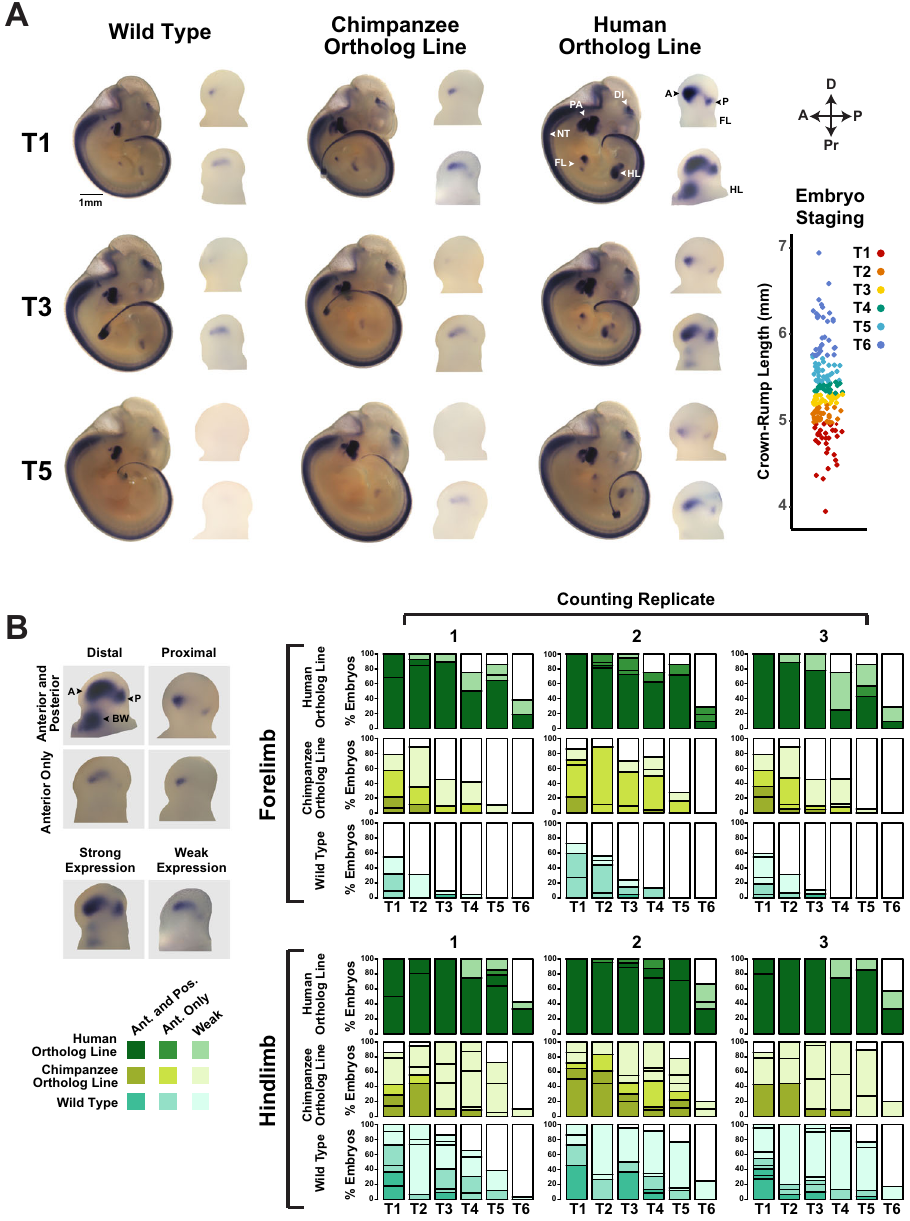
Fig. 3 Spatial and temporal changes in Gbx2 expression driven by HACNS1 in HACNS1 knock-in mouse embryos. A Spatial and temporal expression of Gbx2 in HACNS1 homozygous, chimpanzee ortholog line, and wild type E11-E12 embryos visualized by whole-mount in situ hybridization (ISH). Representative images are shown for each genotype at three fi ne-scale time points; see text and associated Source Data for details on staging. Magni fi ed views of Gbx2 expression in limb buds are shown to the right of each embryo. Annotations of anatomical structures and developmental axes are indicated at the top right: FL forelimb, HL hindlimb, DI diencephalon, NT neural tube, PA pharyngeal arch, A anterior, P posterior. The arrows at the top far right indicate the anterior-posterior (A-P) and proximal-distal (Pr-D) axes for the magni fi ed limb buds. Bottom right: Crown-rump lengths for all embryos assayed for Gbx2 mRNA expression by ISH. Each point indicates a single embryo. Colors denote each fi ne-scale time point (T1-T6). B Left: representative images of anterior, posterior, proximal, distal (top), and strong versus weak Gbx2 staining patterns (bottom). Anterior (A), posterior (P), and body wall (BW) domains are denoted on top left limb bud. Right: Gbx2 ISH staining pattern data across 6 developmental timepoints from each of three independent, blinded scorers (marked at top as counting replicates 1 – 3; see text and Fig. 3A for timepoint scheme and associated Source Data for annotations). The darkest shade for HACNS1 homozygous (dark green), chimpanzee ortholog line (olive), and wild type (teal) represents percentage of forelimbs or hindlimbs showing strong anterior and posterior limb bud staining. Medium-dark shade, as shown in the legend on the left, denotes strong anterior staining only, while the lightest shade denotes weak staining in any domain. Independent biological specimens were analyzed for n = 139 (wild type), n = 103 (chimpanzee ortholog line), and n = 106 (human ortholog line) forelimbs and n = 137 (wild type), n = 103 (chimpanzee ortholog line), and n = 102 (human ortholog line) hindlimbs. For body wall and pharyngeal arch scoring data see Supplementary Fig. 3A, B and associated Source